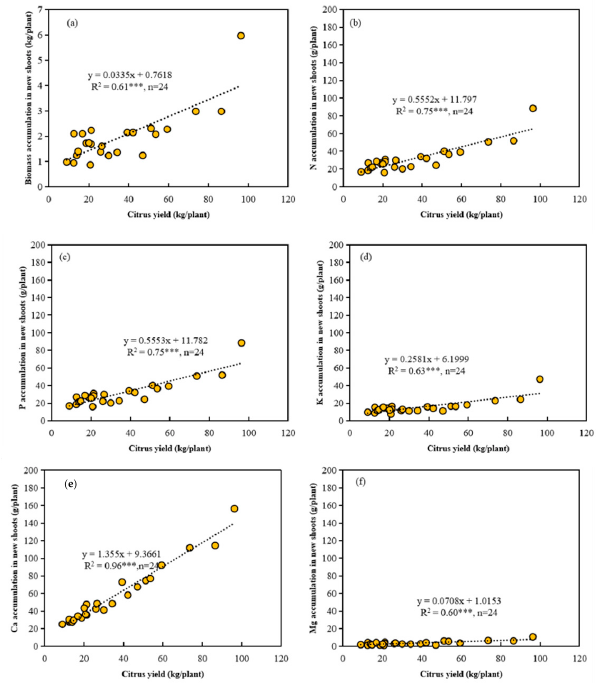
Figure 2. Relationships between citrus yields (kg/plant) and shoot biomass ( a ), nitrogen ( b ), phosphorus ( c ), potassium ( d ), calcium ( e ) and magnesium ( f ) accumulations (g/plant) of citrus trees. The letters denote the panels. *** indicated significance at p < 0.001.